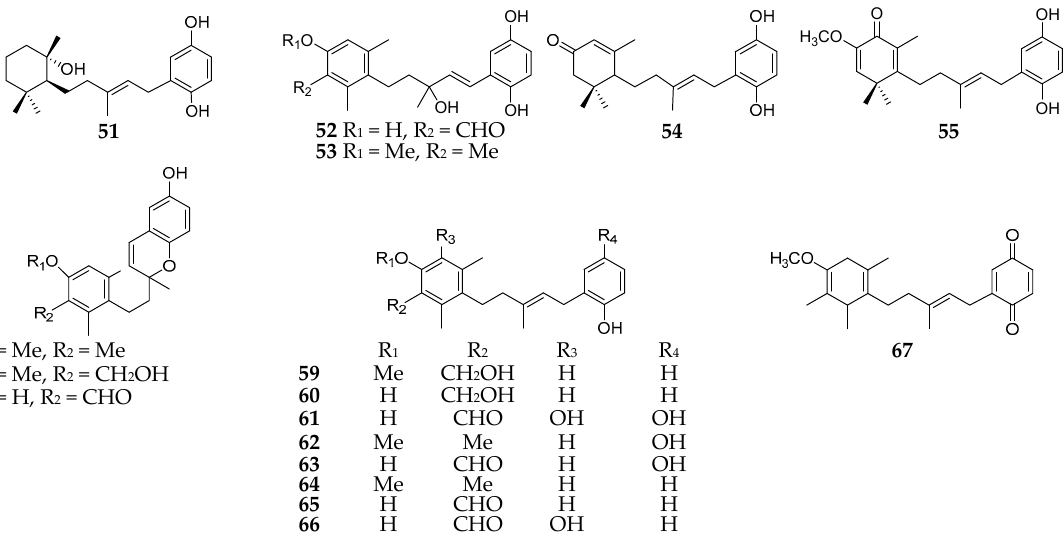
Figure 6. Aromatic polyketides derivatives 51 – 67 from the subgenus Reniera.